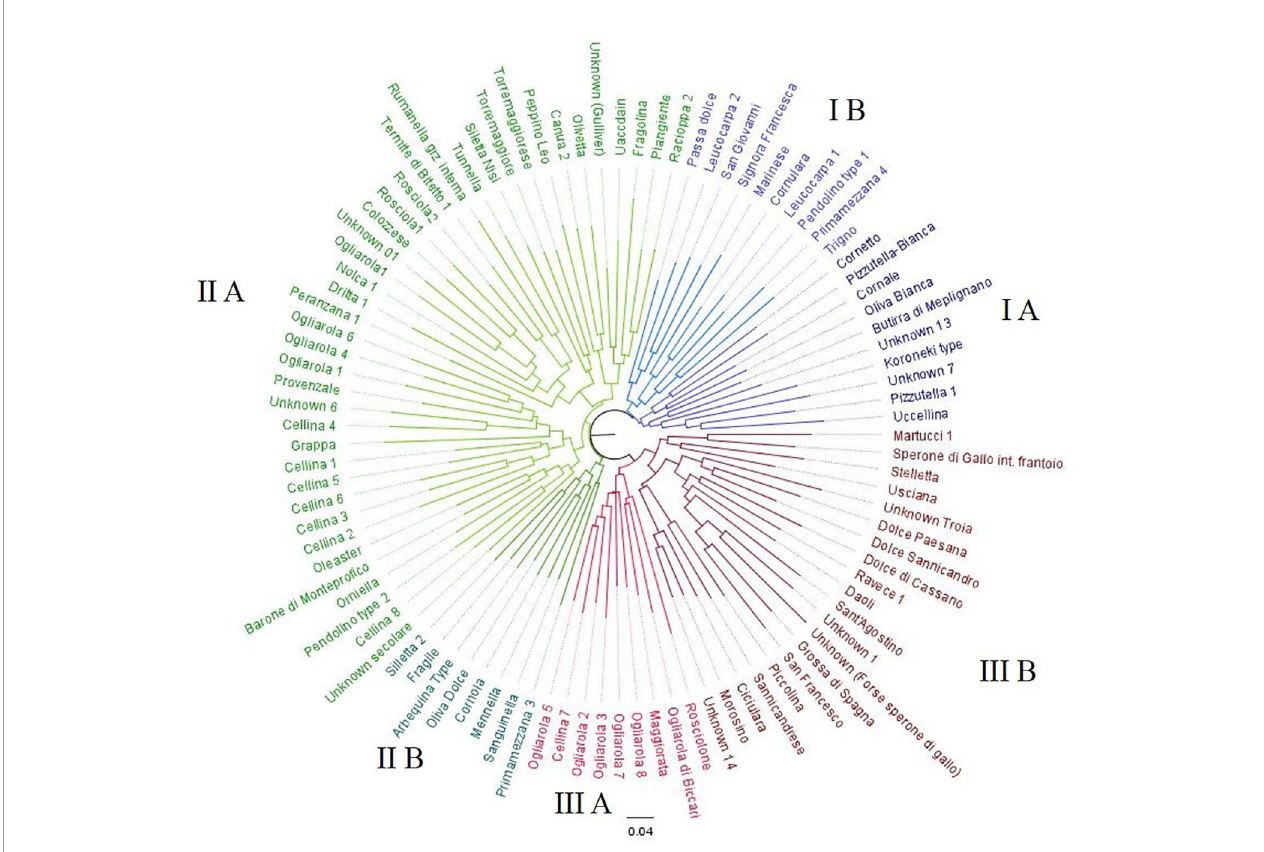
FIGURE 2 | Dendrogram generated by Neighbor-Joining clustering method, illustrating the relationships among 97 olive Apulian genotypes, using the morphological